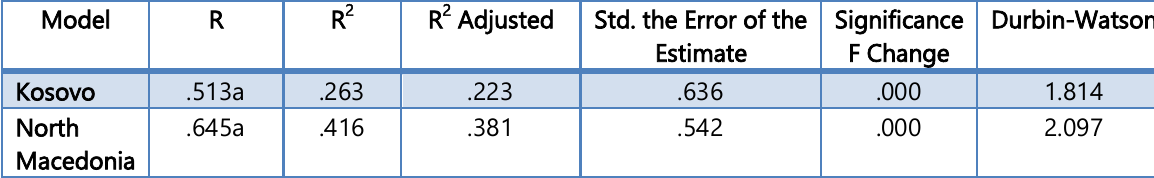
Significance Durbin-Watson Estimate F Change